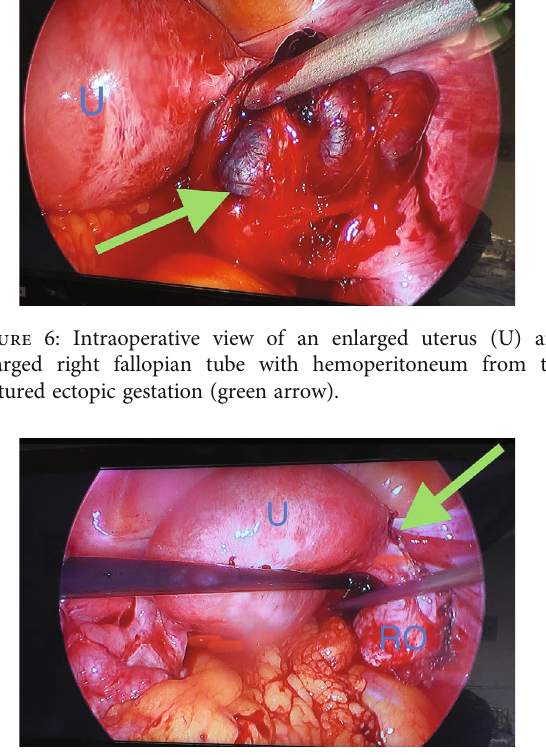
Figure 7: Intraoperative view of an enlarged uterus (U), right ovary (RO), and right salpingectomy (green arrow).